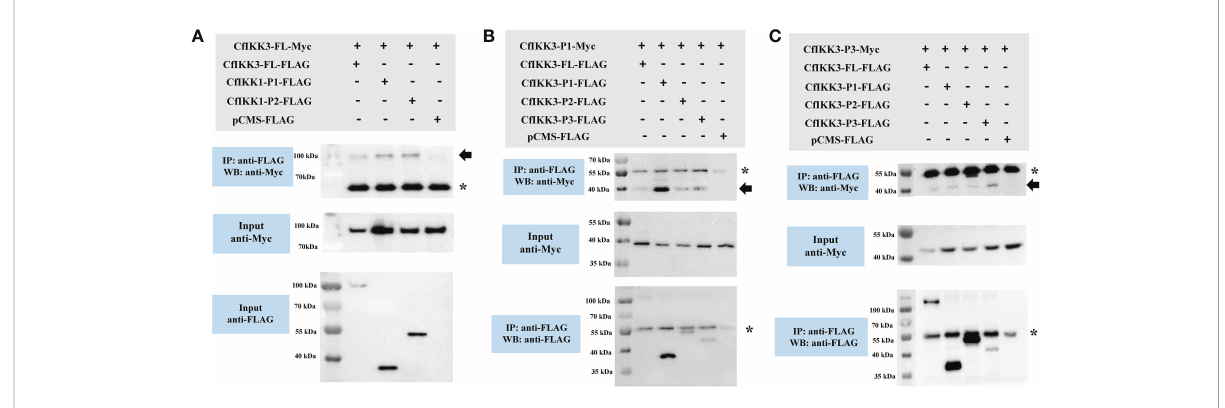
assays. Co-IP results indicated the interaction of CfIKK3-FL-Myc with CfIKK3-FL-FLAG, CfIKK3-P1-FLAG and CfIKK3-P2-FLAG. (B) Interaction between the CfIKK3 kinase domain (CfIKK3-P1-Myc) and various CfIKK3-FLAG proteins (CfIKK3-FL, CfIKK3-P1, CfIKK3-P2, and CfIKK3-P3), as veri fi ed using co-immunoprecipitation assays. The results showed that CfIKK3-P1-Myc could interact with CfIKK3-FL-FLAG, CfIKK3-P1-FLAG, CfIKK3-P2-FLAG, and CfIKK3-P3- fl ag. (C) Interaction between the CfIKK3 CCD1 domain (CfIKK3-P3-Myc) and various CfIKK3-FLAG proteins (CfIKK3-FL, CfIKK3-P1, CfIKK3-P2, and CfIKK3-P3), as veri fi ed using co-immunoprecipitation assays. The results showed that CfIKK3-P3-Myc could interact with CfIKK3-FL-FLAG, CfIKK3-P1-FLAG, CfIKK3-P2-FLAG, and CfIKK3-P3- fl ag. Asterisk represents the heavy chain of mouse